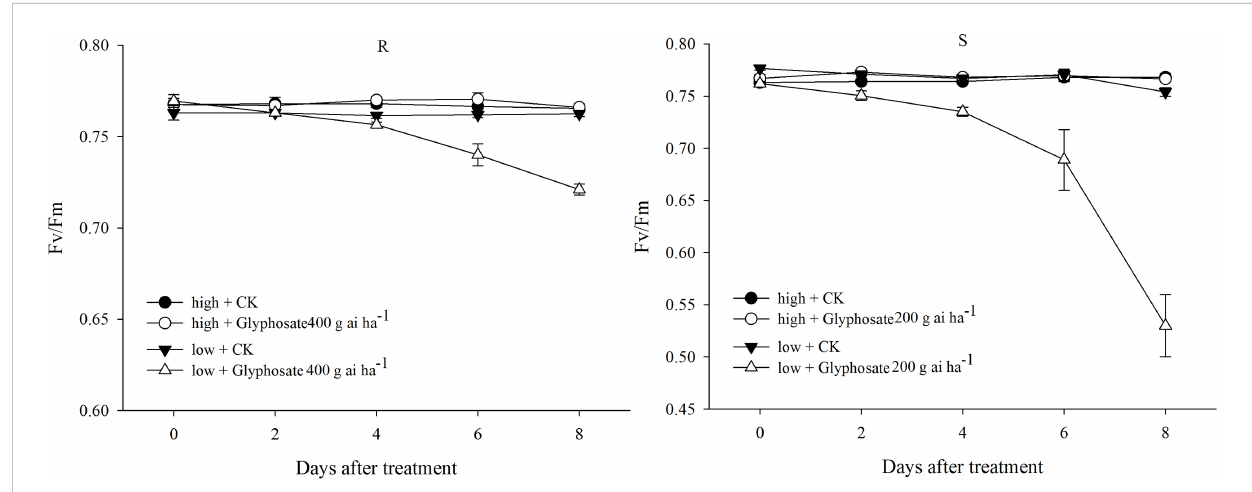
FIGURE 3 Fv/Fm value of glyphosate-resistant (R) and -susceptible (S) Eleusine indica biotypes after glyphosate treatment under high temperature (30°C/25°C day/night) and low temperature (20°C/15°C day/night) regimes. Each data point is the mean ± standard error of four biological